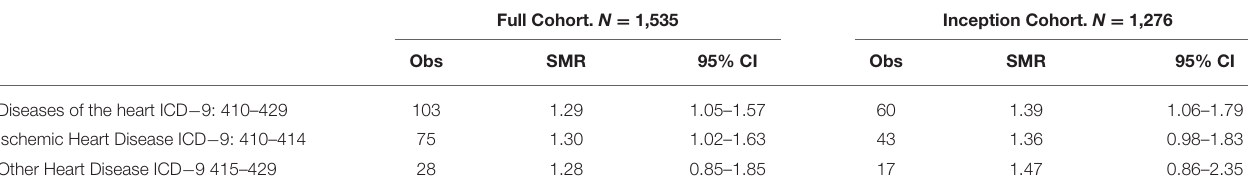
TABLE 3 | Cardiac mortality in German cohort: reference population: West Germany (from 17).